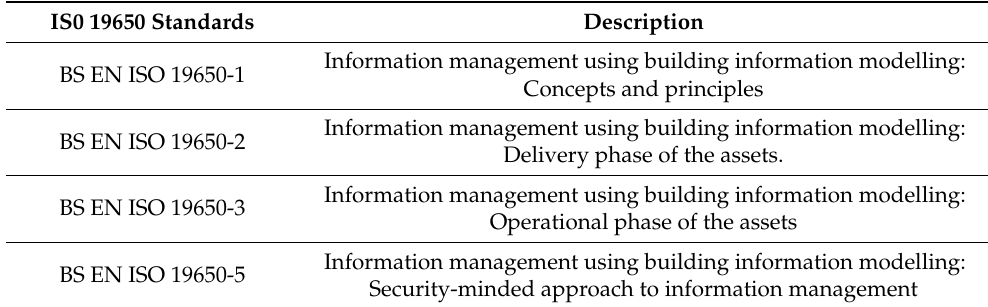
Table 9. BIM 1SO 19650 standards (information retrieved from